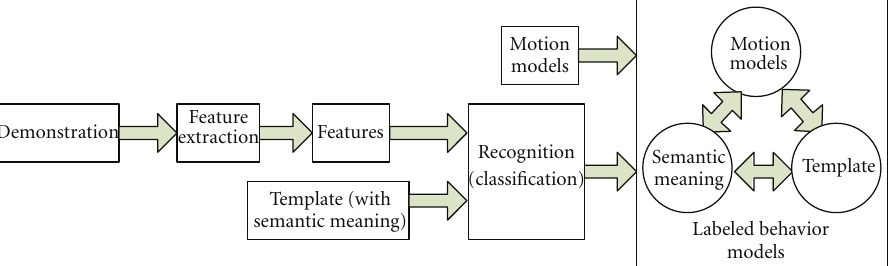
Figure 2: Learning of motion models and semantic